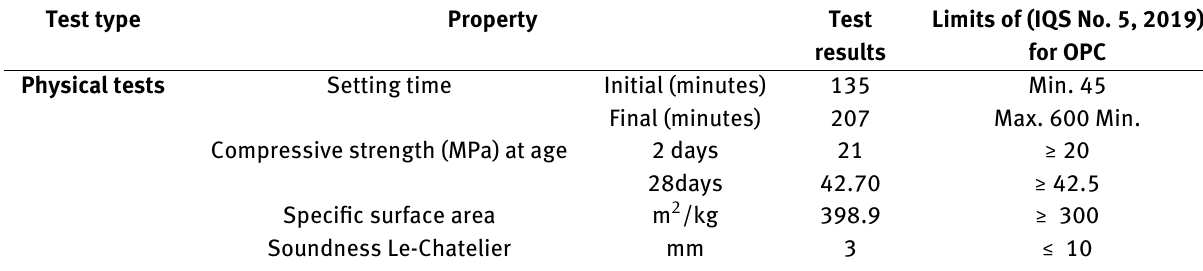
Table 1: Physical properties of cement Test